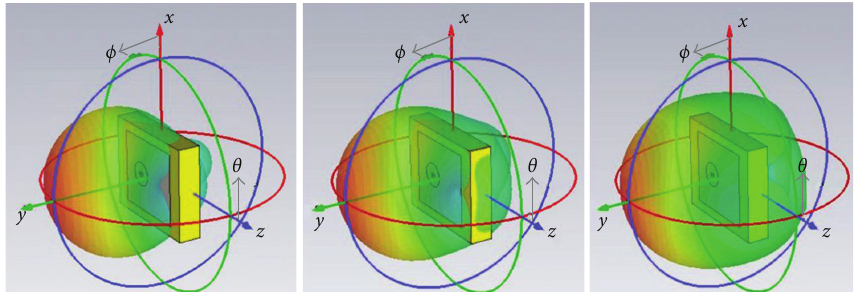
Figure 3: Patch antenna power radiation pattern at 1.71, 1.905 and 2.05 GHz.